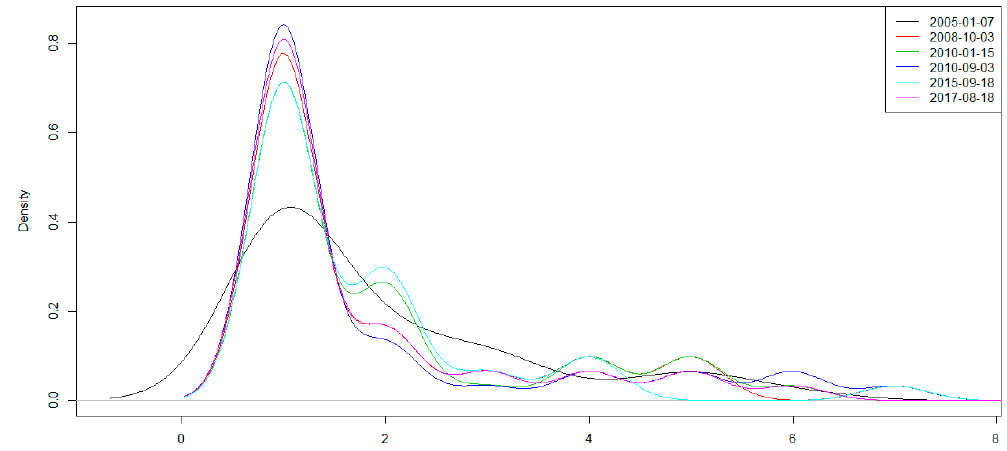
Figure 1. Degree distribution of selected minimum spanning trees. Source: Own study.